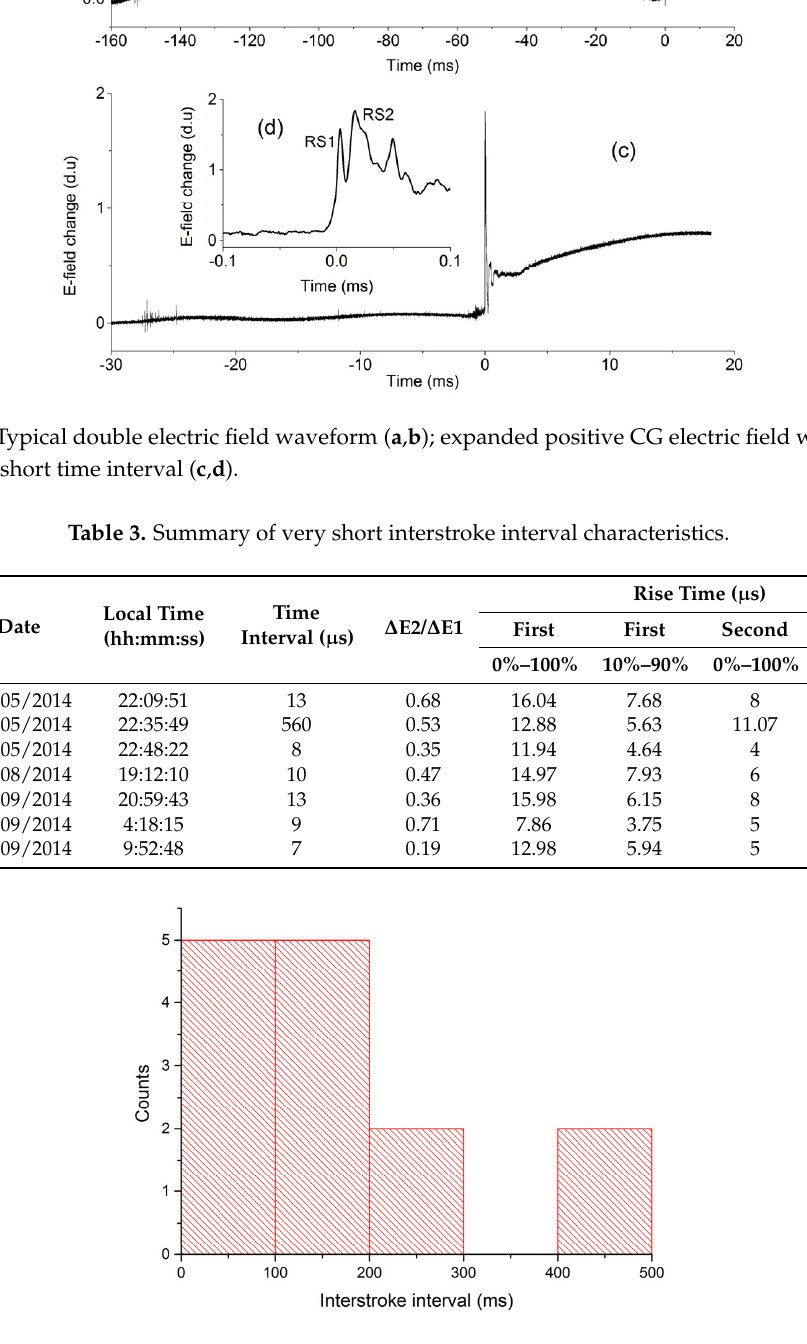
Figure 5. Interstroke interval histogram for 27 strokes of 13 positive CG flashes. Table 4. The summary of very short time interval of two terminations return stroke.